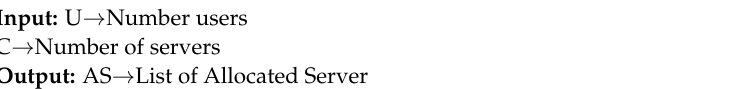
Algorithm 1. Algorithm of TGA (Task Group Aggregation)